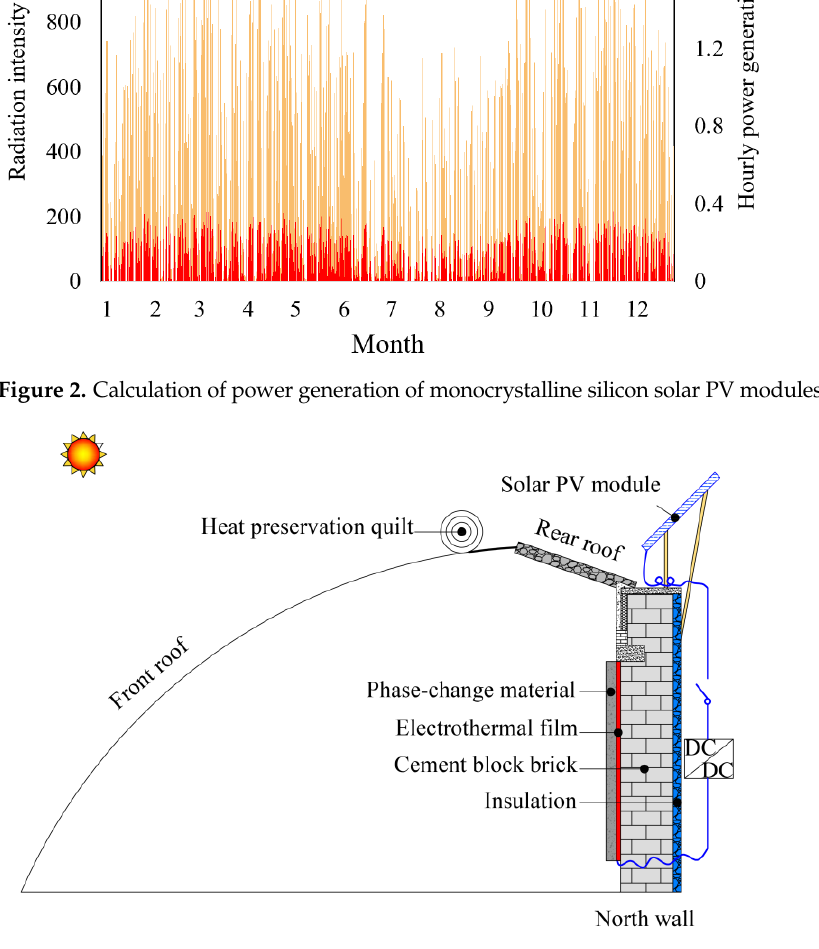
Figure 3. “ Four-layer ” structure composite phase change heat storage heating wall of a solar photovoltaic electric-thermal